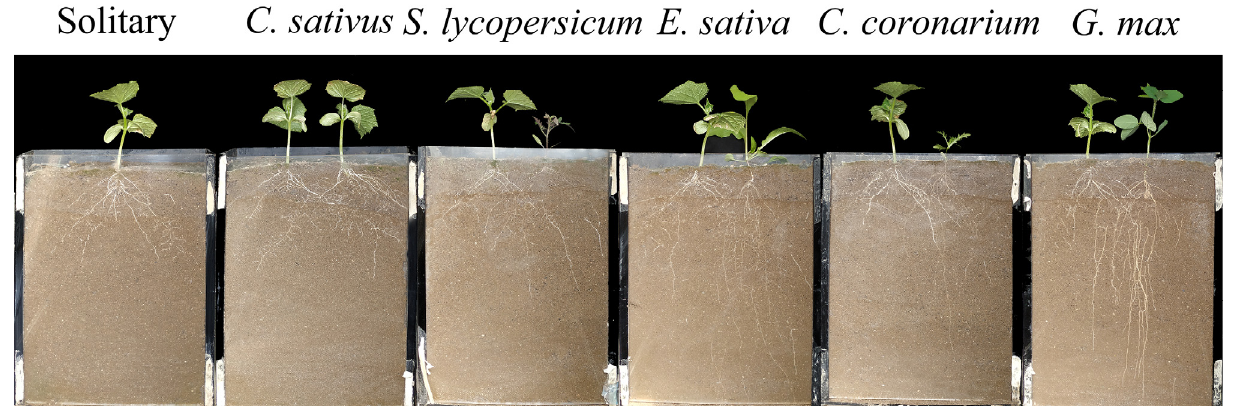
Figure 1. Phenotypic plasticity responses of roots to different neighbor combinations.